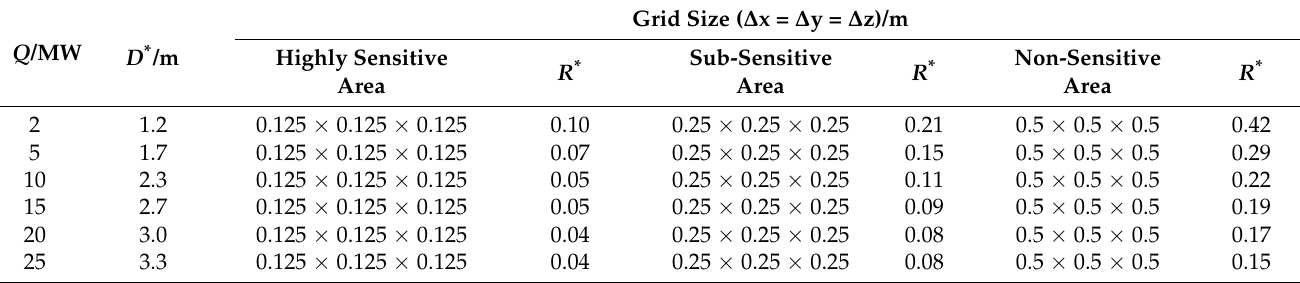
Table 3. Summary of grid size in the FDS LES